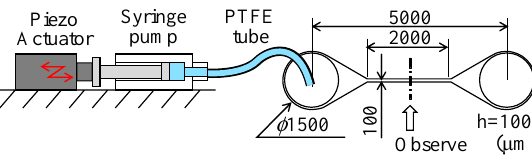
Figure A1. The channel design of the straight-line